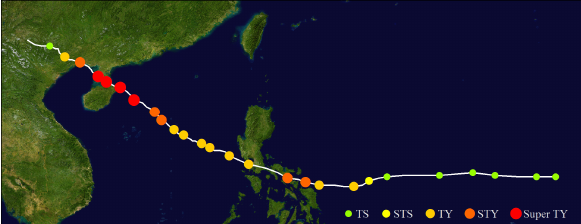
Figure 3. The track-intensity map of Typhoon Rammasun (201409)